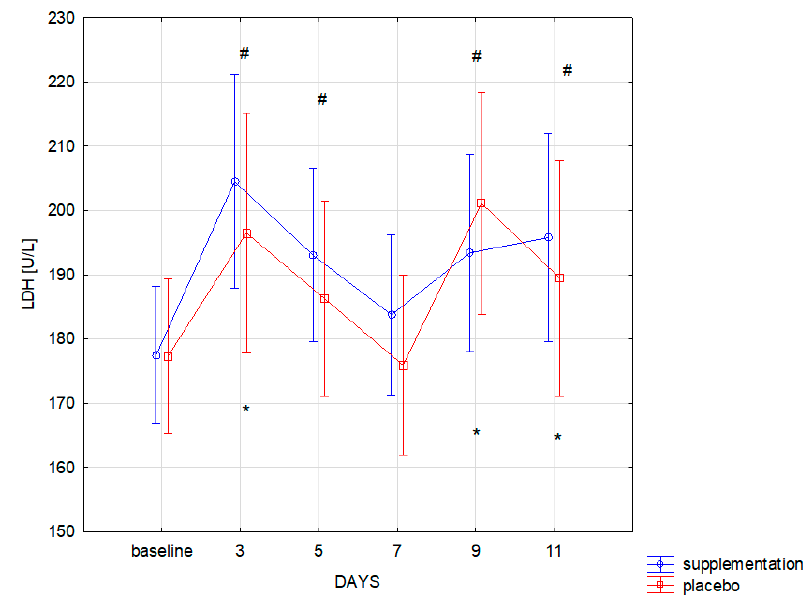
Figure 3. Lactate dehydrogenase (LDH) concentration in subsequent days in SUP and PL groups (* significant change ( p < 0.05) to baseline in PL group; # significant change ( p < 0.05) to baseline in SUP